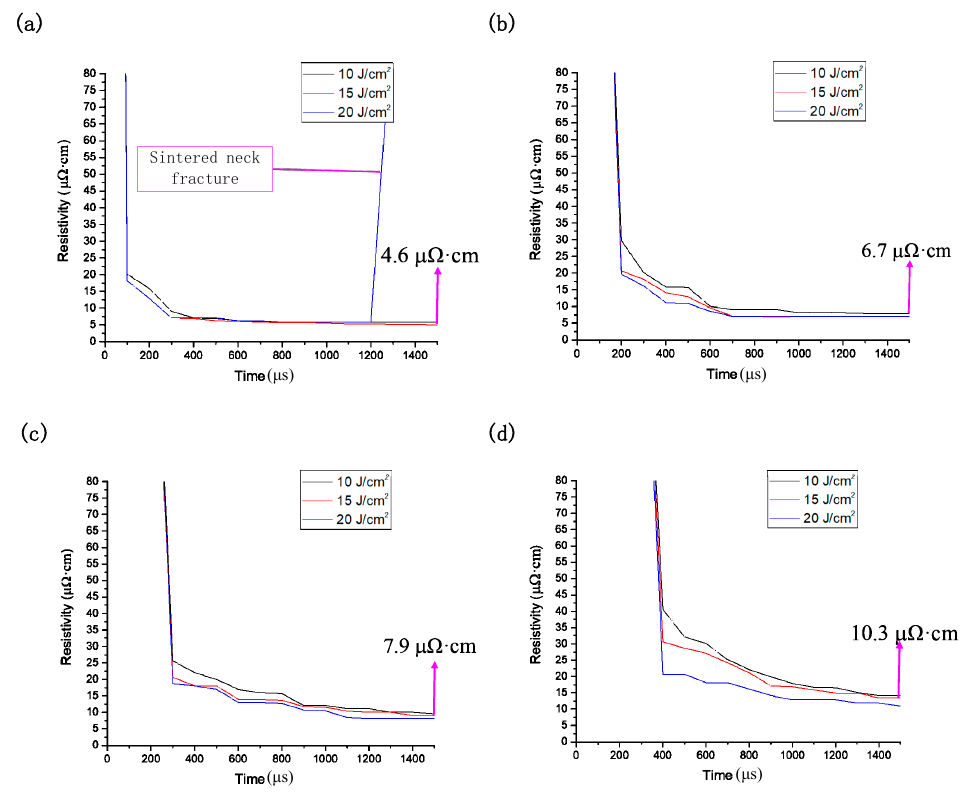
Figure 9. Simulation of the change in resistivity of different sintered power densities for nanoparticle radii of ( a ) 5 nm; ( b ) 10 nm; ( c ) 15 nm; and ( d ) 20 nm.